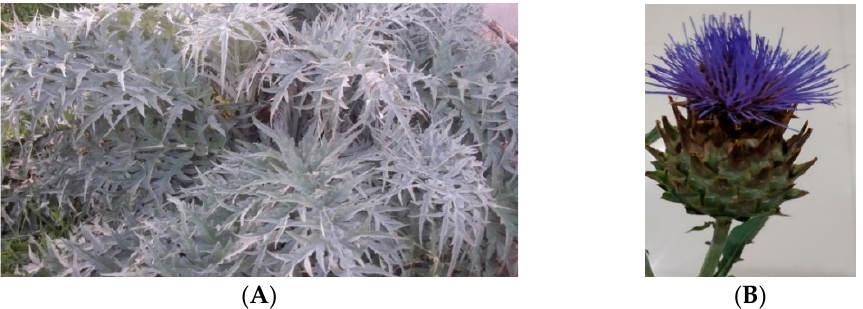
Figure 1. Cynara cardunculus (n ° LISU266732) morphology of leaves ( A ) and inflorescence ( B ).